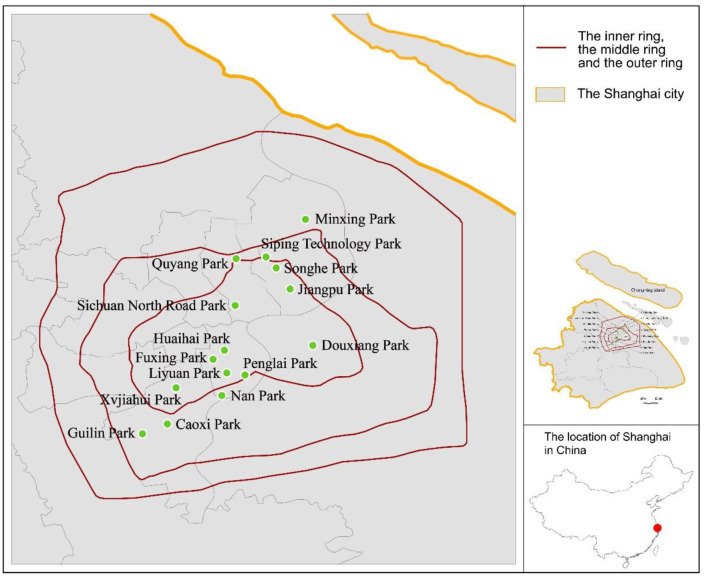
Locations of the 15 neighborhood parks in Shanghai.